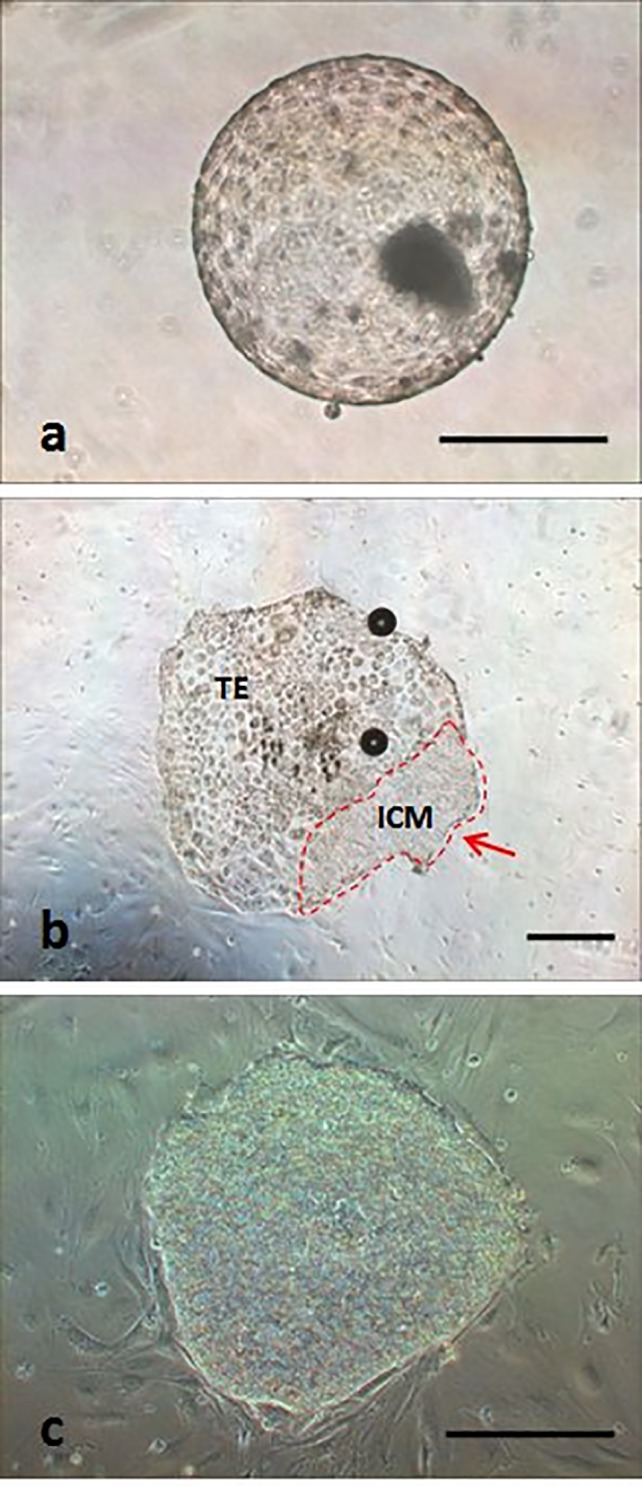
Formation of ntES cell colonies derived from the blastocyst embryos of the 3× cloned embryos.(a) A 3× blastocyst embryo (day 7) and (b) embryonal outgrowths with clearly ICM cells (red arrow) after culture for 5–8 days. (c) Typical morphology of a putative porcine ntES cell colony after passage. Scale bar = 100 μm.